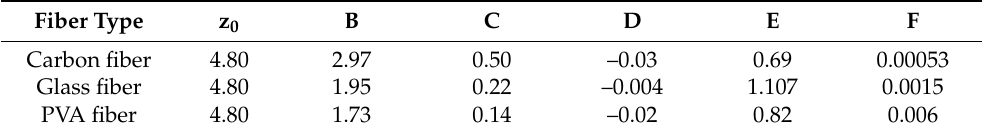
Table 8. Different fiber